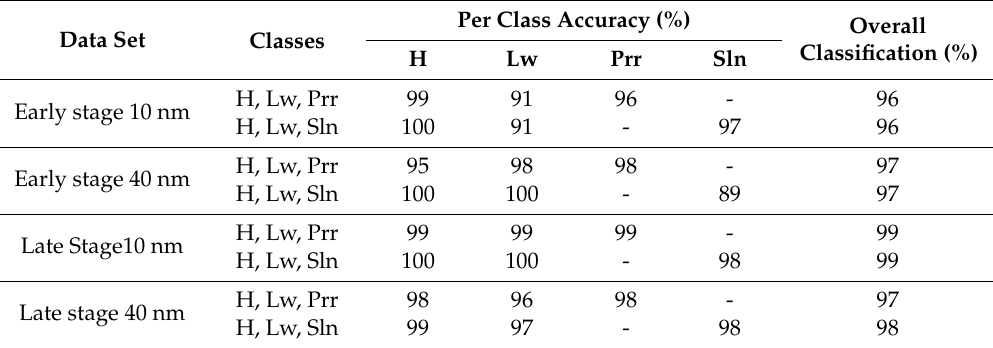
Table 2. Percentage of correct classification of early and late stage of healthy (H), laurel wilt (Lw), Phytophthora root rot (Prr) and salinity damage (Sln) using 10 and 40 nm bandwidth in the in the multilayer perceptron (MLP)